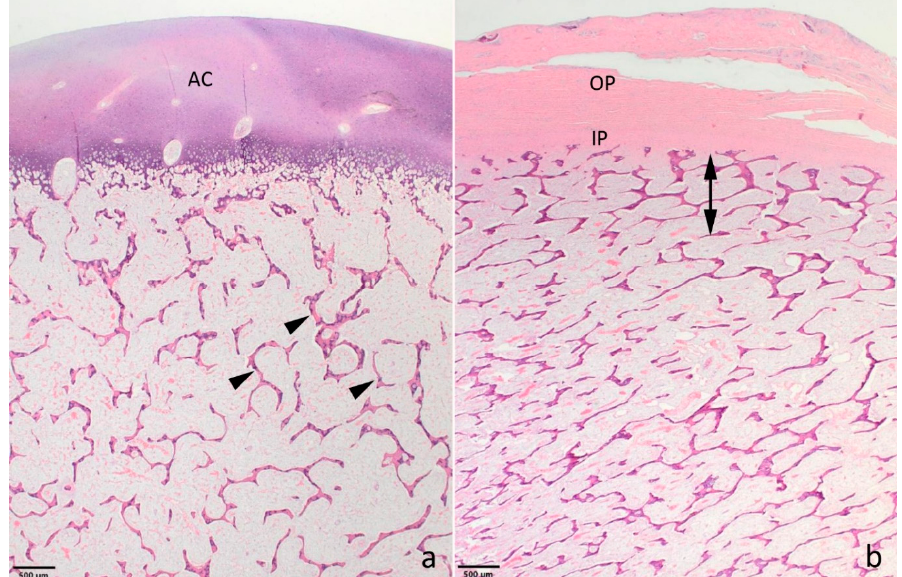
Figure 2. Photomicrographs showing the bone morphology of the OI affected Holstein calf. ( a ) The epiphyseal spongiosa is characterized by small trabeculae with remnants of chondroid matrix (arrow heads). The amount of spongious bone